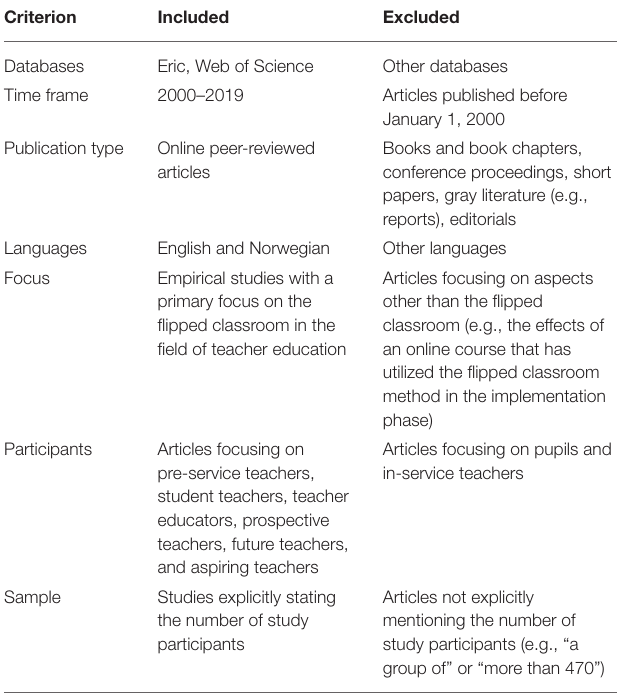
TABLE 2 | Inclusion and exclusion